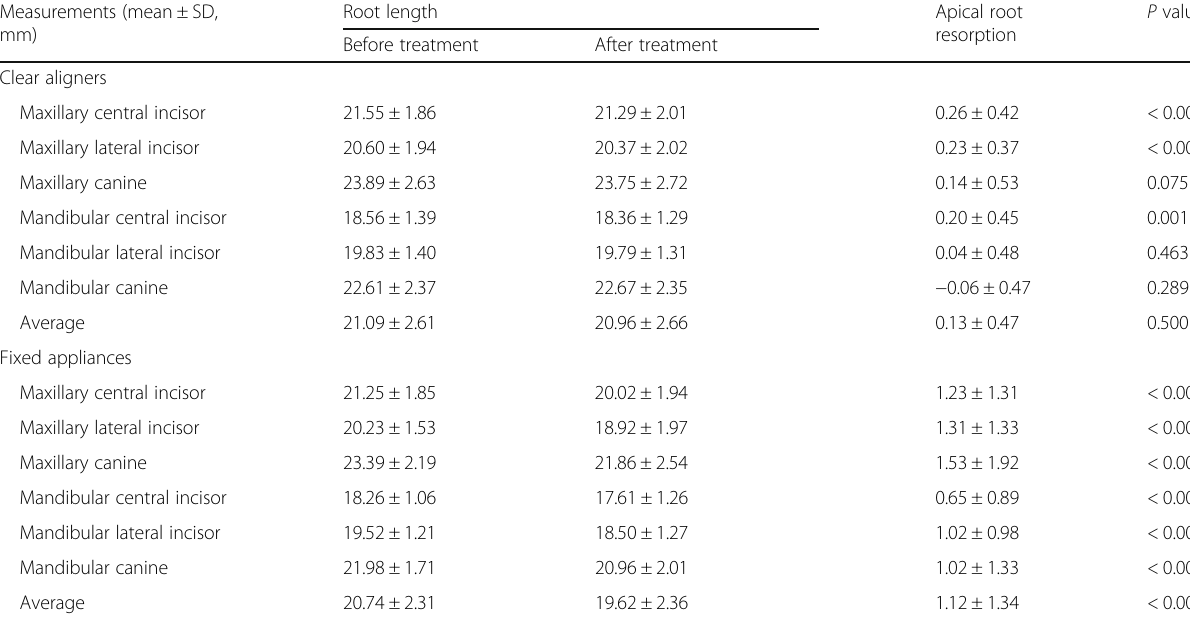
Table 4 Severity of apical root resorption of individual tooth in the two groups Measurements (mean ± SD, mm)